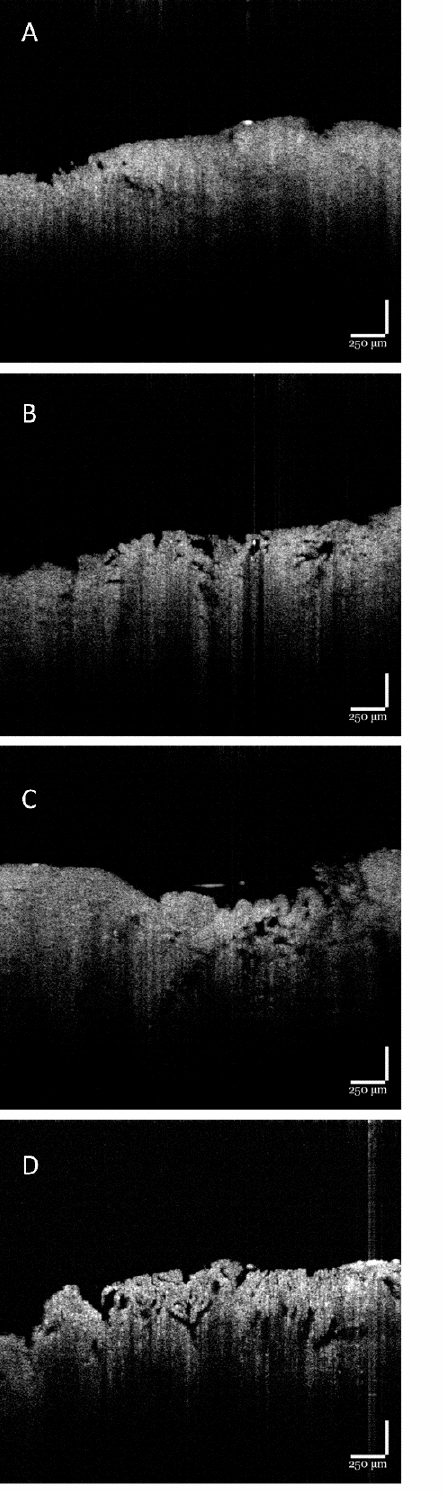
Figure 3. OCT images of cryogel scaffolds: ( A ) 100:0 0B, ( B ) 100:0 1B, ( C ) 100:0 2B, ( D ) 100:0 3B, ( E ) 50:50 0B, ( F ) 50:50 1B, ( G ) 50:50 2B, and ( H ) 50:50 3B. Scale bar is 250 µm. The SEM images veri fi ed the OCT images of both series of the cryogels. In the dehy- drated state, the 100:0 series showed long, collimated and densely packed fi brous mor- phology with low macro-pores, whilst the 50:50 series exhibited short, randomly orien- tated fi brous morphology with macro-pores. In the lower borax content samples, cavities